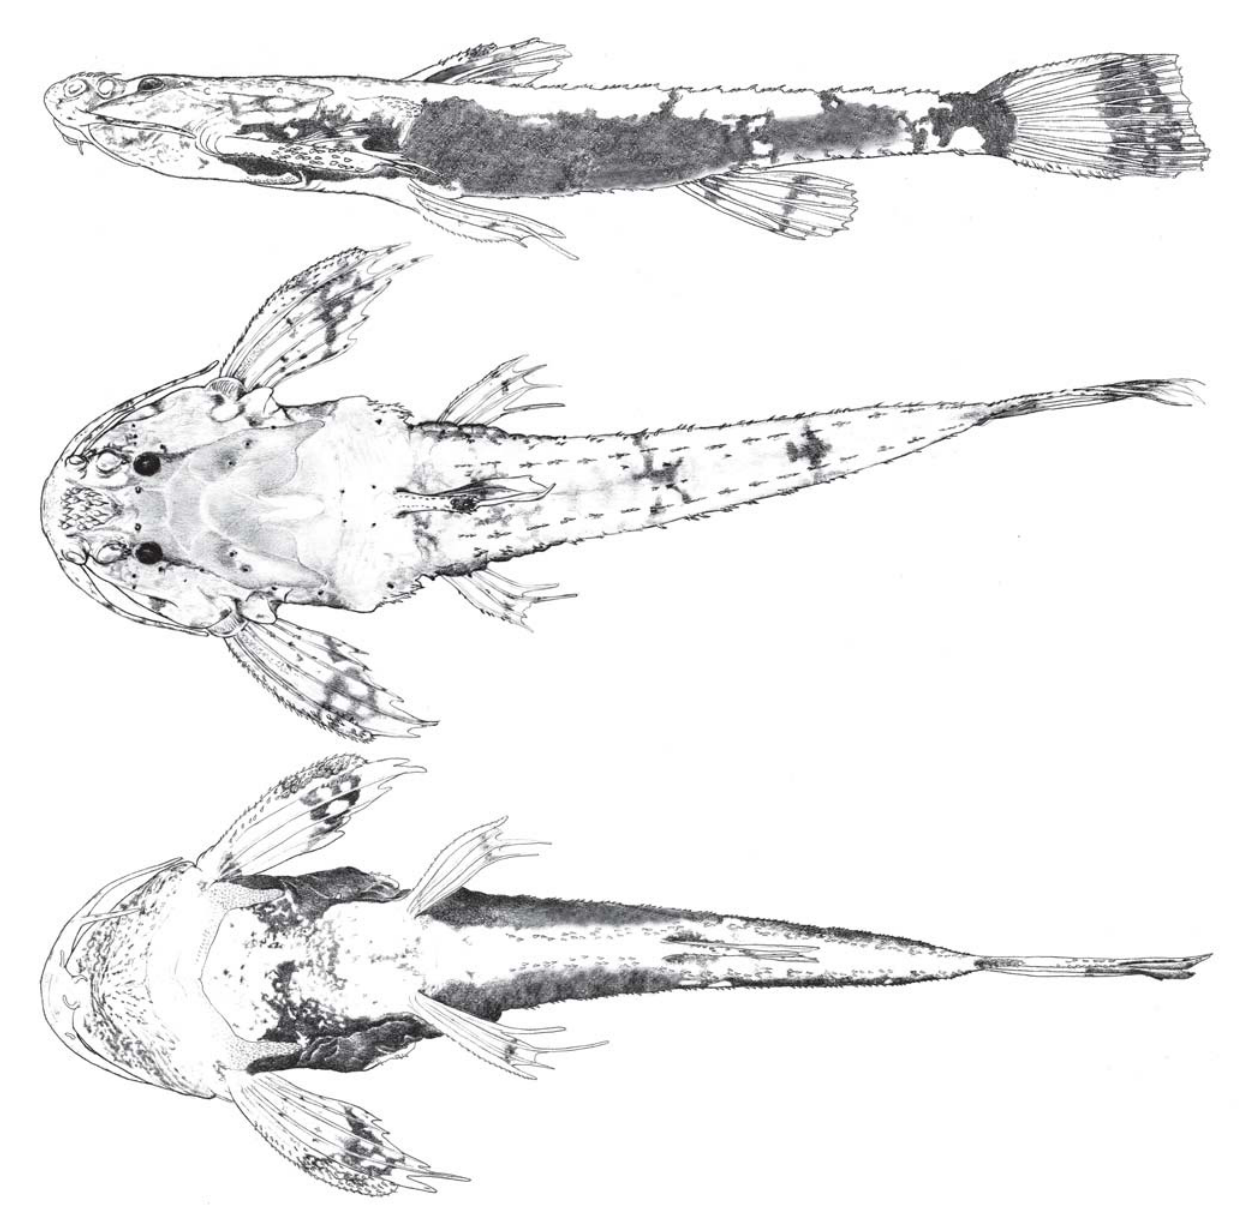
Fig. 2. Scoloplax baskini , INPA 28649, paratype, 16.3 mm SL, in lateral (top), dorsal (middle) and ventral (bottom) views. Illustration by Deyse